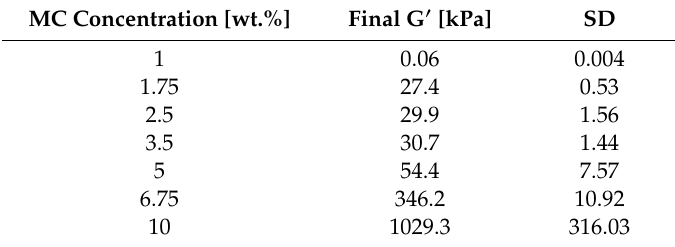
Table 1. Final storage modulus, G (cid:48) , determined for several MC